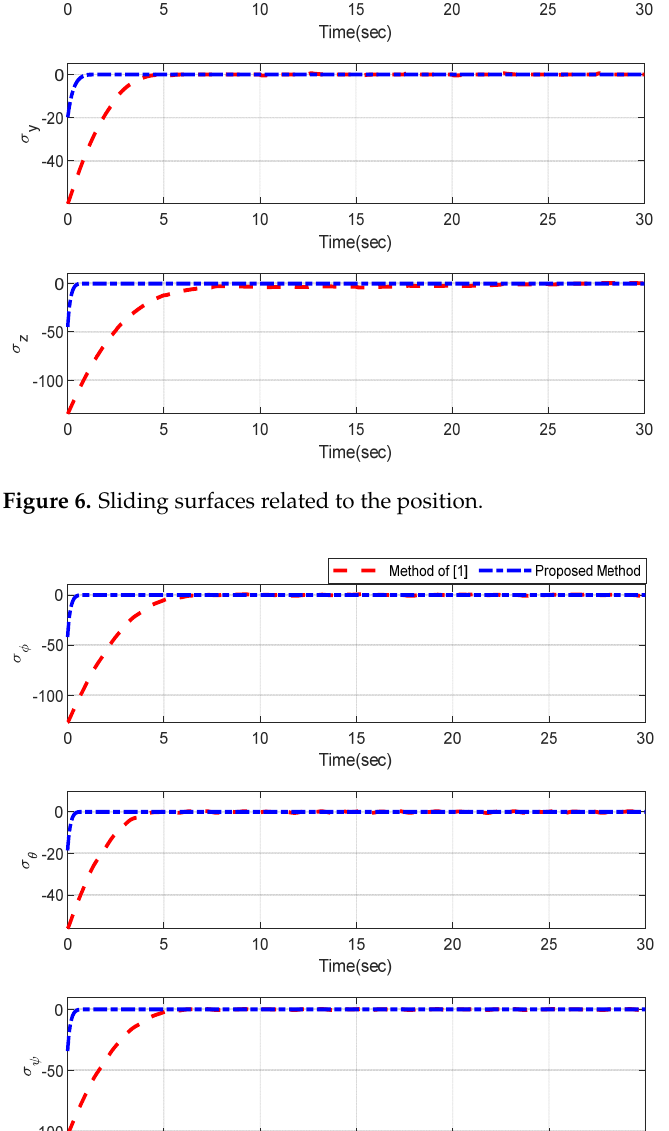
Figure 7. Sliding surfaces related to the attitude .